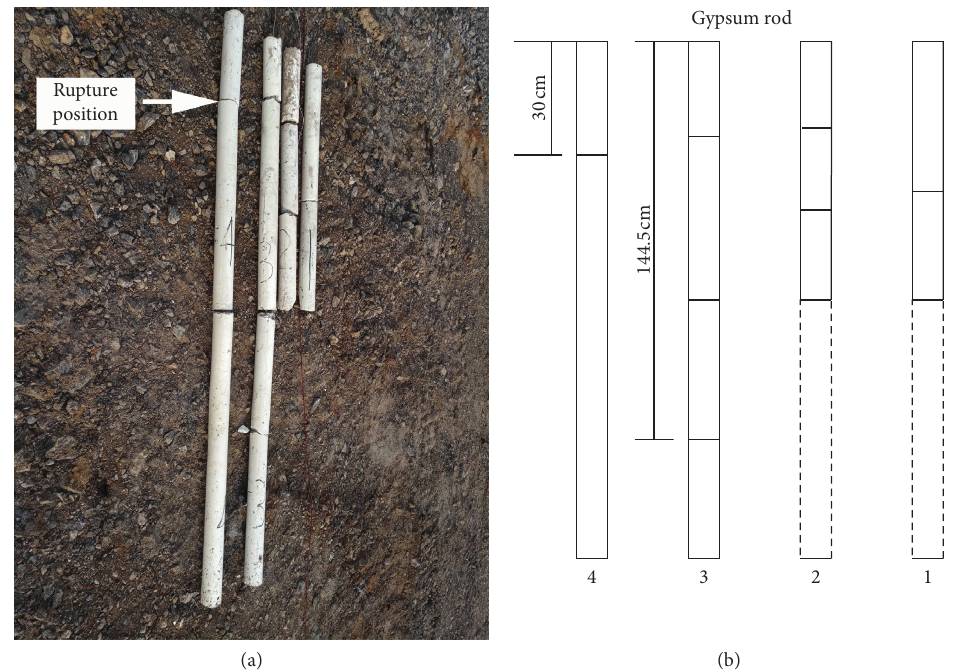
Figure 9: Gypsum rod after the blasting test: (a) field observation; (b) measured data.